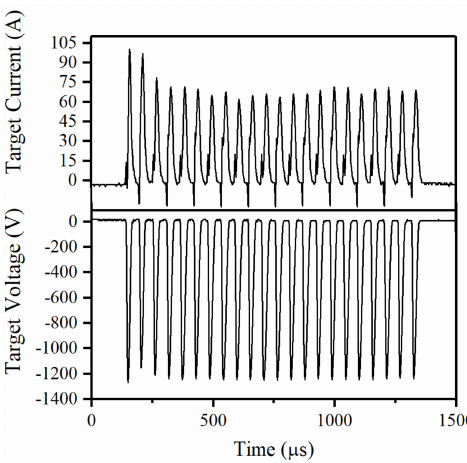
Figure 1. The target voltage and current oscillation waveforms measured during the Ta coating